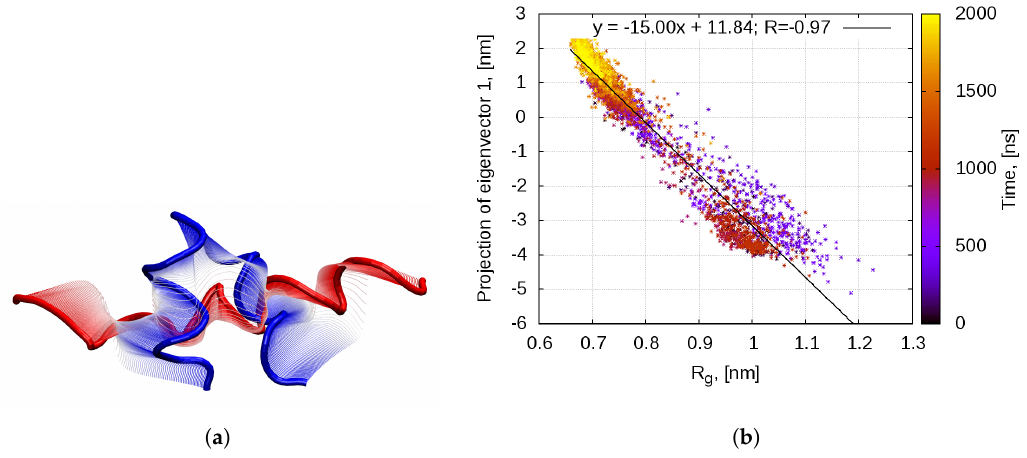
Figure 3. ( a ) Bombinin H2 peptide backbone motion along the first principal component; and ( b ) correlation between the projection of first principal component and the gyration radius of the